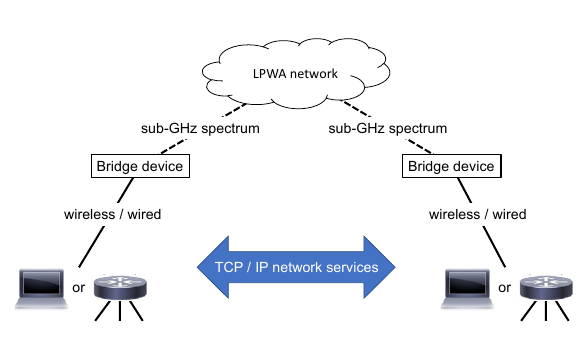
Figure 2. Overview of network system with sub-GHz band communication bridge.